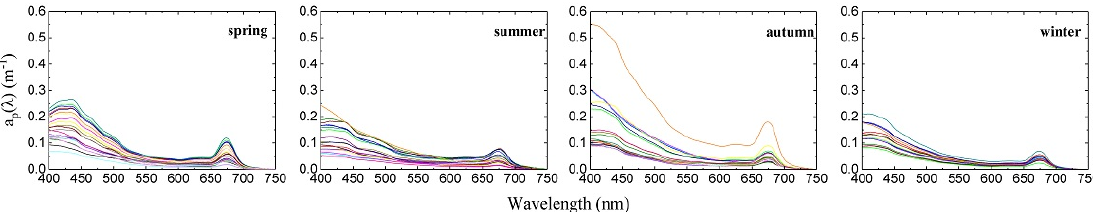
Figure 2. Total particle spectral absorption coefficients, ( )